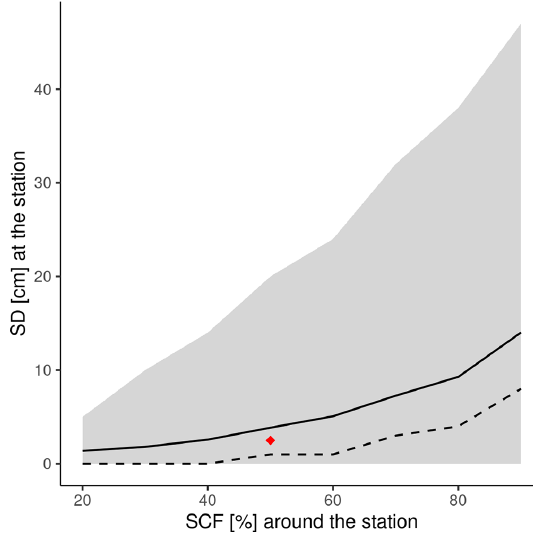
Figure 2. Relationship between the snow cover fraction (SCF) around the station and the snow depth (SD) at the station in all RIHMI sites. Solid and dashed lines represent the mean and median value, respectively. The gray shaded region shows the 5th and 95th percentiles. The red dot represents the threshold of 2.5cm selected to convert SD into